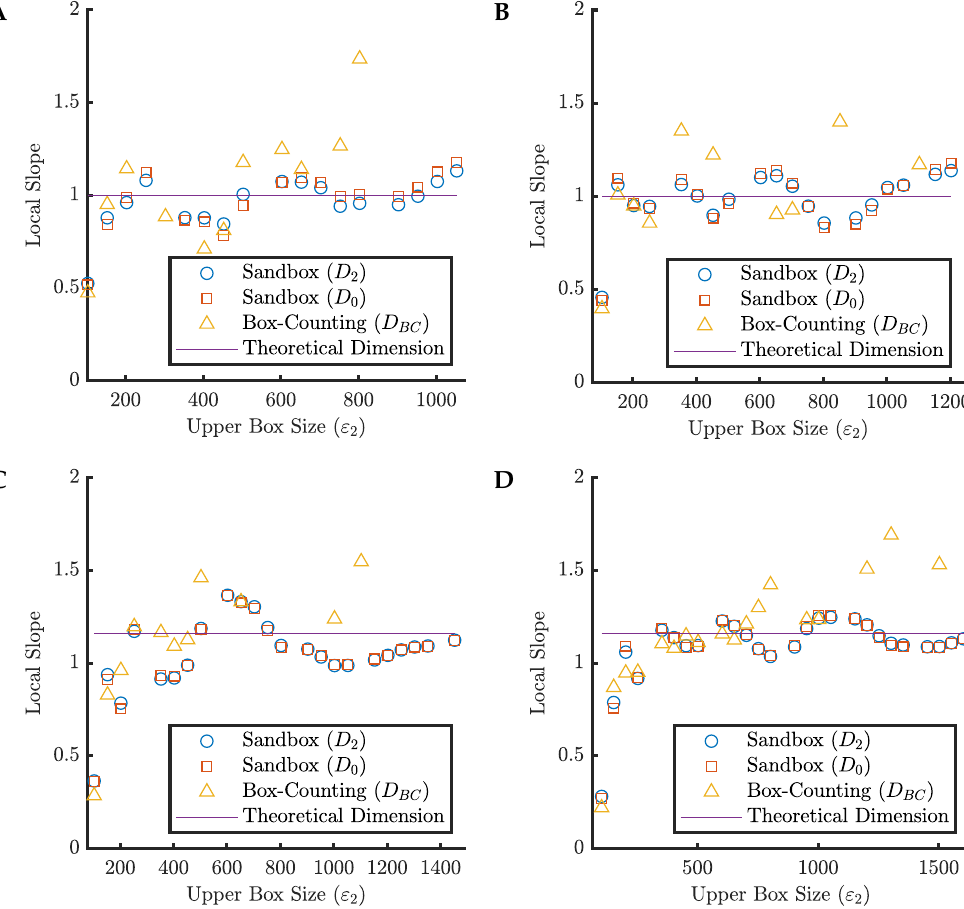
Figure 9. Plots showing the local slopes as a function of the upper box size ε 2 for four distinct fractal tree canopies. ( A ) r = 0.5, θ = π /4. ( B ) r = 0.5, θ = π /3. ( C ) r = 0.55, θ = π /4. ( D ) r = 0.55, θ = π